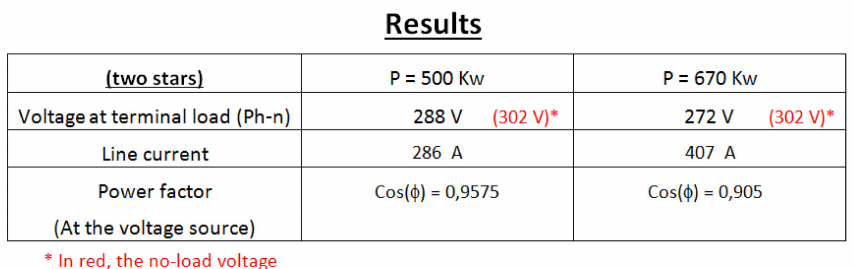
Figure 24. Results of the simulation. It can be noticed that voltage drop remains under 10% at full